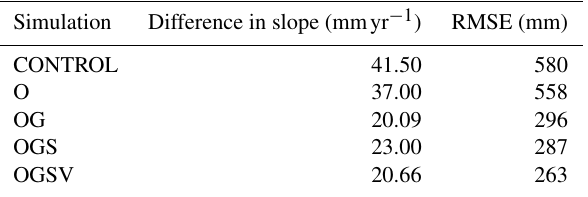
Table 5. The RMSE and difference in slope calculated between the rainfall reconstruction and simulations in the period from 1972 to 2000CE. The difference in slope is the difference of the slope of the ordinary least squares linear fitted CUSUM time series data for each sample to the slope of the fitted CUSUM time series data for rainfall reconstruction in the period from 1972 to